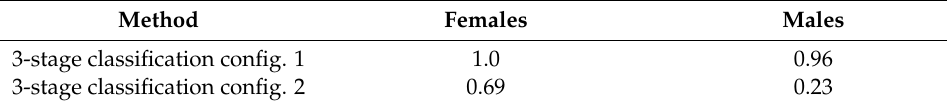
Table 6. Two 3-stage classification accuracies.